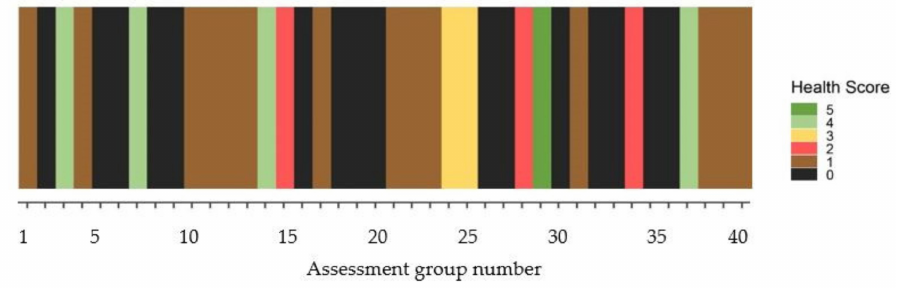
Figure 8. Heatmap of south infestation transect assessment points. Group 1 was located at the northernmost point, Group 40 closest to the treated area to the south. Health score ratings, 5 = highest health score (>95% alive); 4 (71–95% alive); 3 (51–70% alive); 2 (31–50% alive); 1 (<30% alive); 0